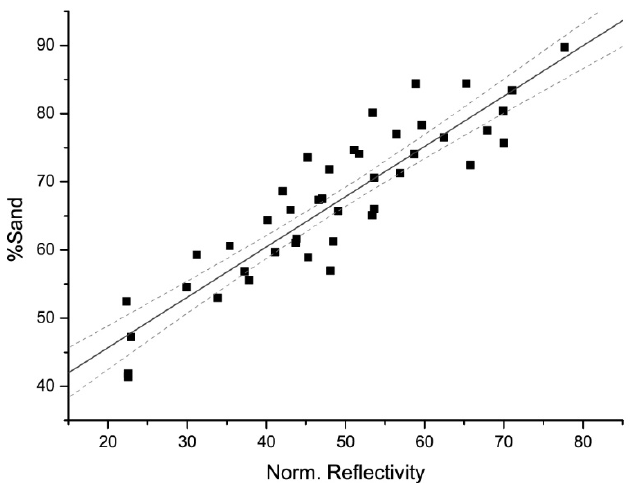
Figure 3. Reflectivity vs. % of sand of bottom samples obtained in Valle Fattibello [43]. Reflectivity values were normalized between maximum (71.46%) and minimum (0.85%) occurrence of sand.